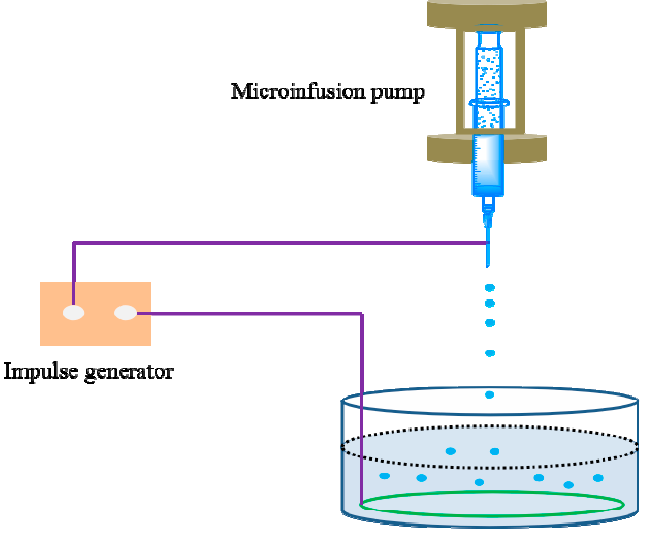
Figure 1. The impulse electrostatic device.